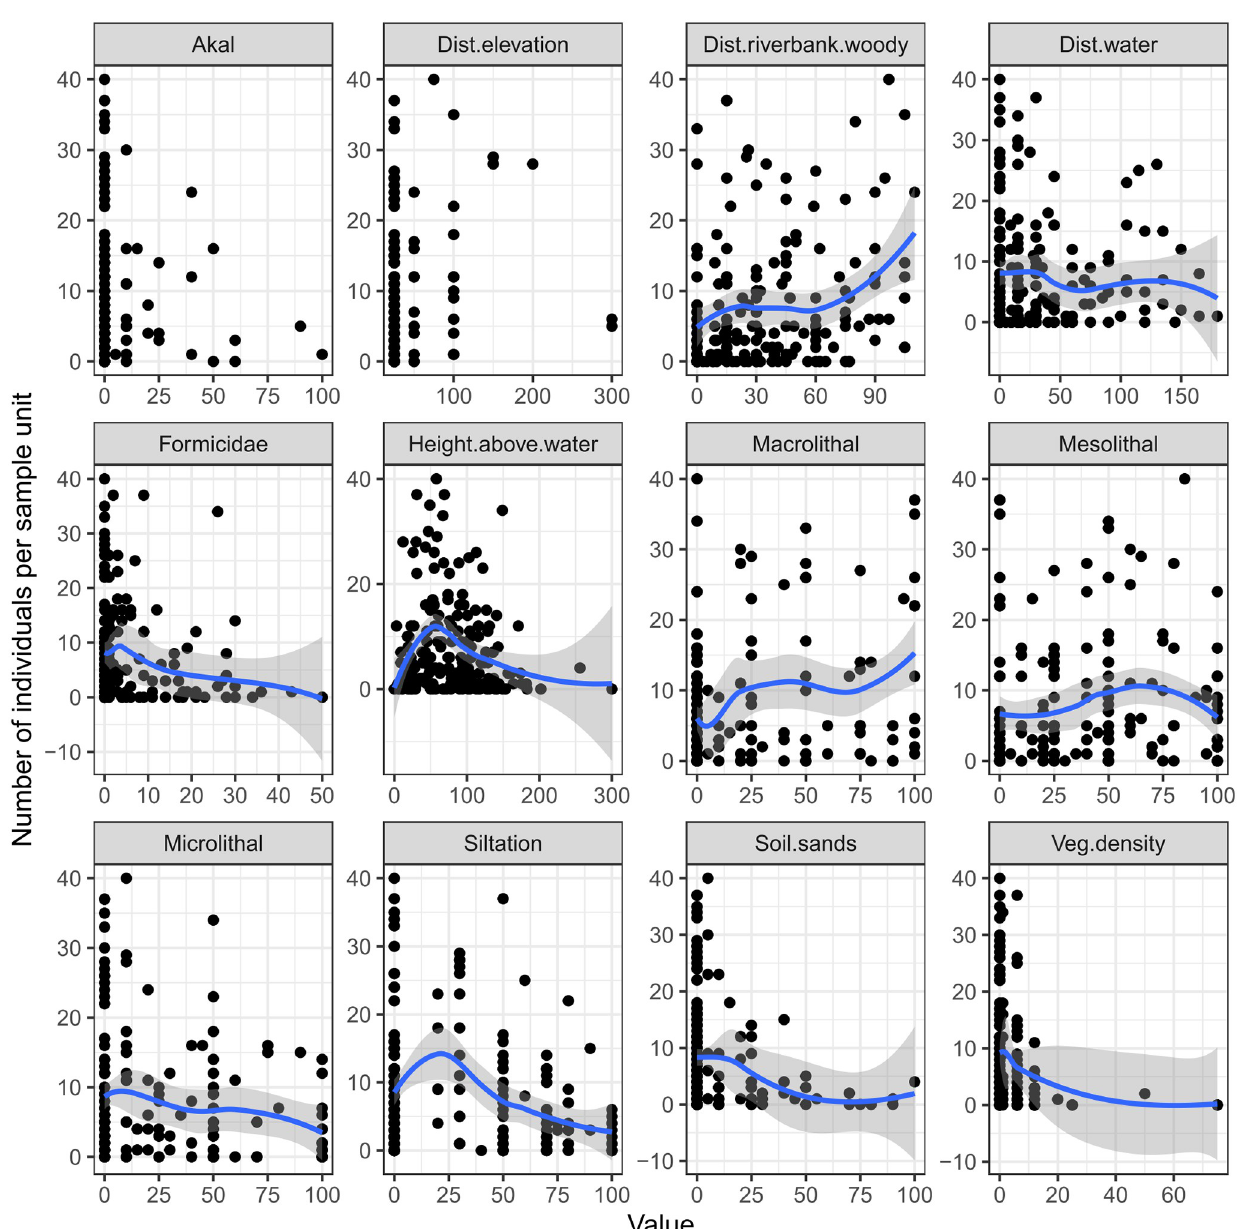
Fig 3. Number of pooled individuals of P . wagleri , A . cinerea and P . rubrothoracicus per sample unit plotted against 12 different habitat variables. The blue line represents the results of the locally weighted